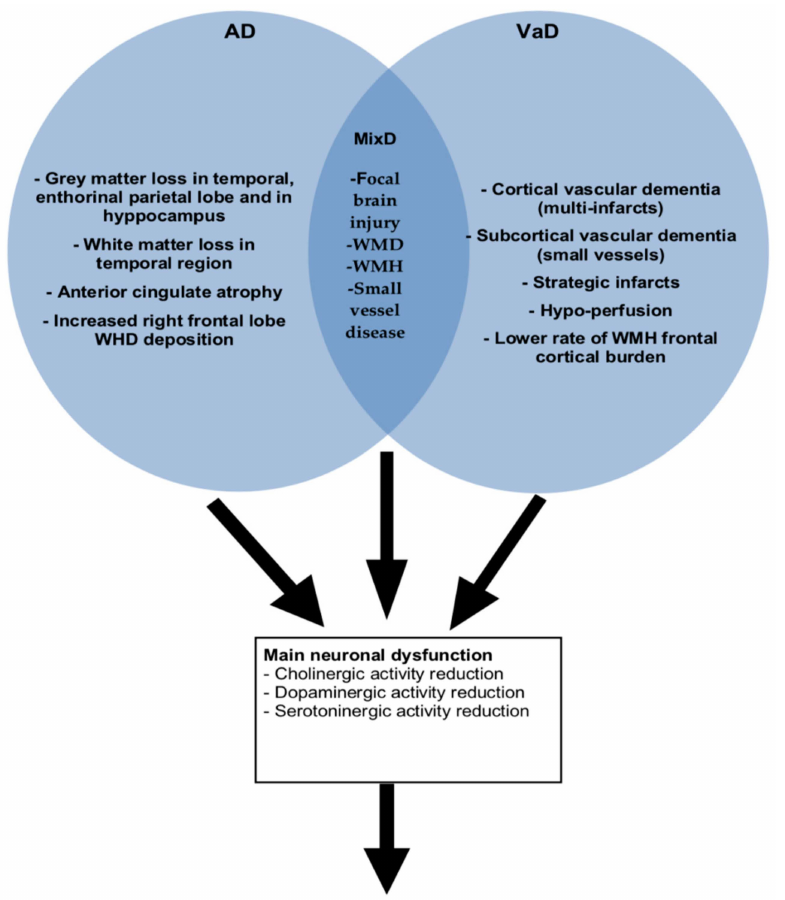
Figure 1. BPSD overlap and patterns according to specific dementia sub-types on the basis of the altered neuroanatomic